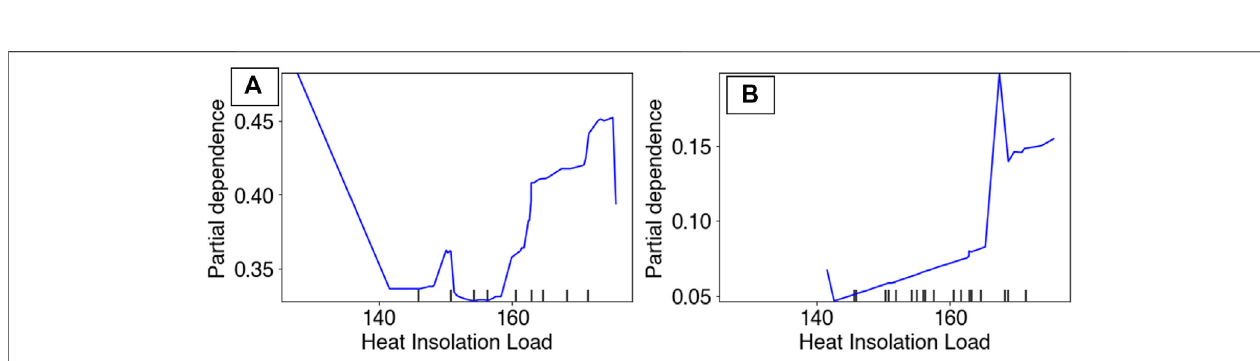
FIGURE 9 | Partial dependency plots for Heat Insolation Load in both the RBT occurrence ensemble (A) and the hybridization ensemble (B) models.